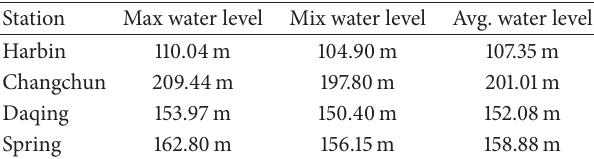
Table 5: Water table in Heilongjiang and